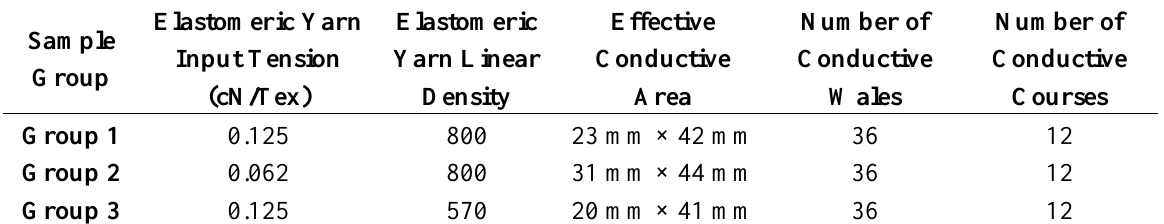
Table 1. Manufacturing parameters of knitted